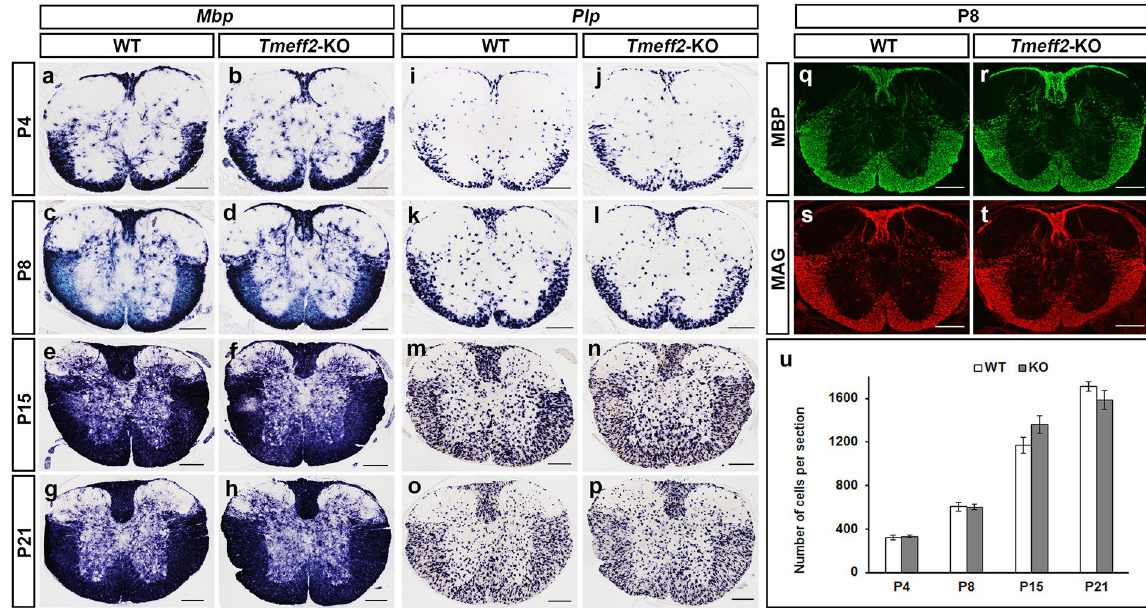
Figure 6. Normal differentiation of OLs in Tmeff2 -KO mutant spinal cords. ( a–p ) Spinal cord sections of wild type and Tmeff2 -KO mice were subjected to ISH with Mbp ( a–h ) and Plp ( i–p ) riboprobe at different stages. ( q–t ) Immunofluorescent staining with anti-MBP ( q,r ) and anti-MAG ( s–t ) in P8 wild type ( q,s ) and mutant ( r,t ) spinal tissues. Bar, 200 μ m. ( k ) Statistical analysis of the number of Plp + OLs in spinal cords from P4 to P21 stages. n = 3, p > 0.05.